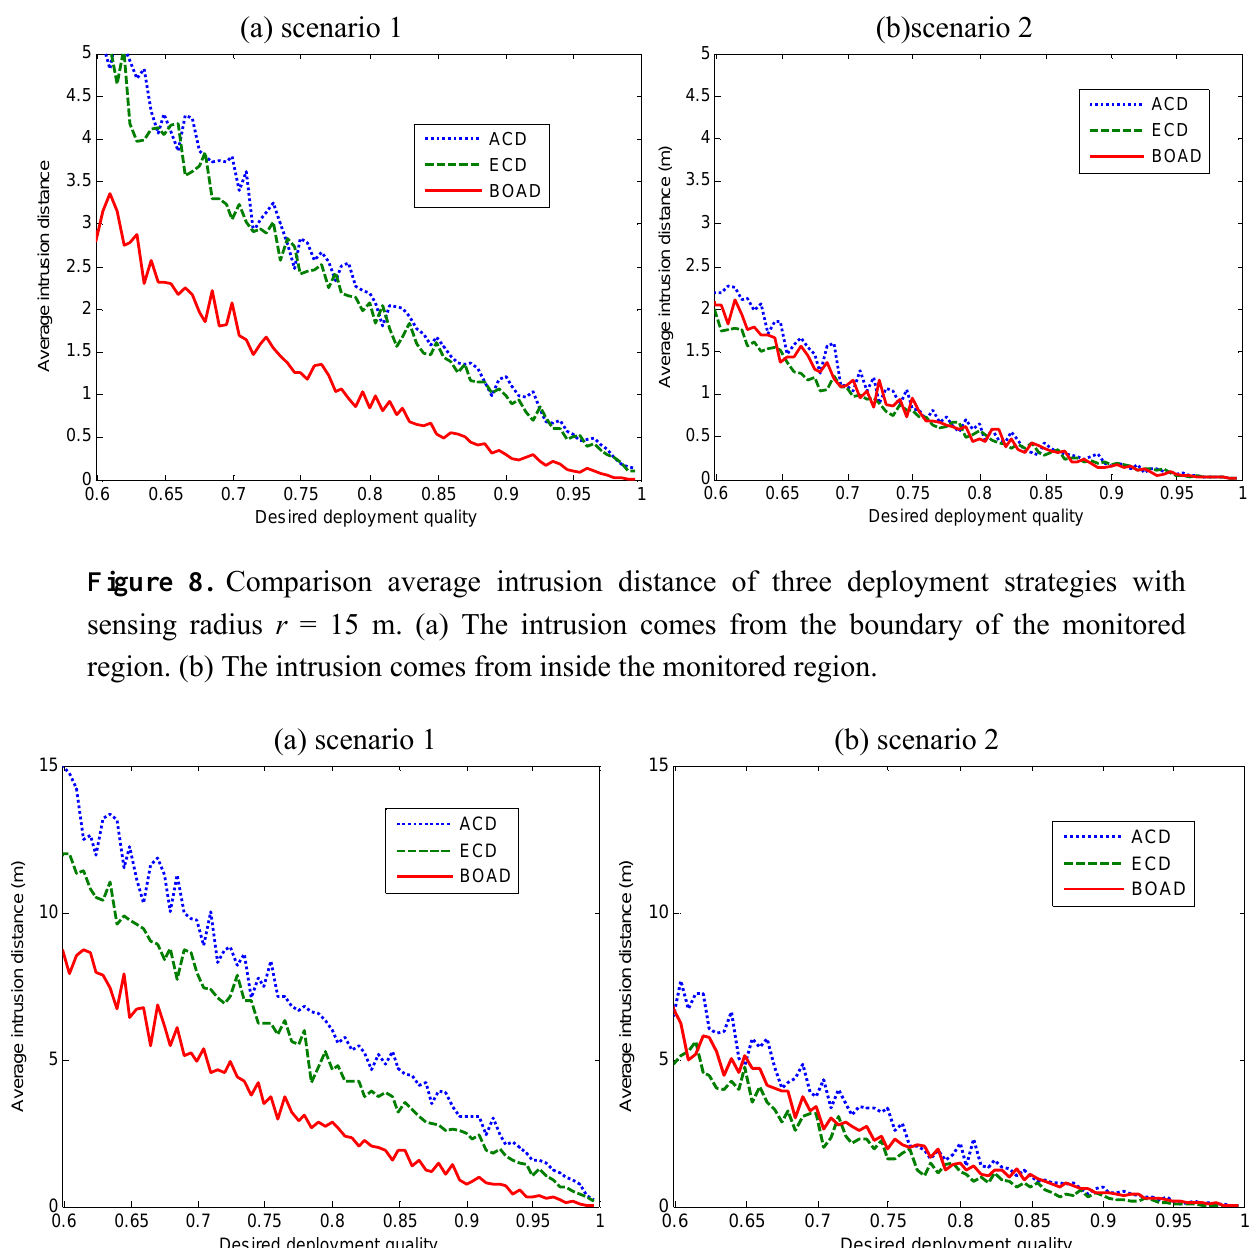
Figure 7. Comparison average intrusion distance of three deployment strategies with sensing radius r = 5 m. (a) The intrusion comes from the boundary of the monitored region. (b) The intrusion comes from inside the monitored region.